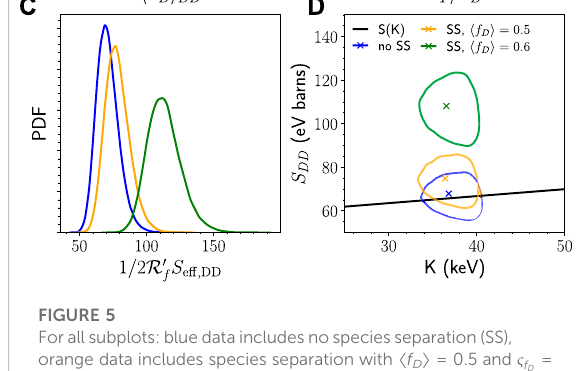
FIGURE 5 Forallsubplots:bluedataincludesnospeciesseparation(SS), orange data includes species separation with 〈 f D 〉 = 0.5 and ς f 0.1 and green data includes species separation with 〈 f D 〉 = 0.6 and ς f = 0.1. (A) Plot showing the probability distribution D functions (PDFs) for the inferred D (D,n) 3 He burn averaged deuteron temperature. The long tail arises from the unknown fl uid velocity variance contribution to the spectral temperatures. (B) Plot showing the inferred ratio of triton to deuteron temperatures. (C) Plot showing the PDFs of the inferred product of effective S-factorandspeciesseparationterm. (D) Plotshowingtheinferred and “ true ” [8] nuclear S-factors from the synthetic data study. The crosses denote the centroid of the PDF and they are surrounded by the 1 σ contour. In inferring the nuclear S-factor from R f ′ S eff , we use the “ hydrodynamic ” value R f ′ (cid:2) 2 which is set by the initial 50/ 50 DT fi ll. The MCMC was performed with the Python library emcee [19], PDFs shown use ~80,000 samples, see Table 1 for more